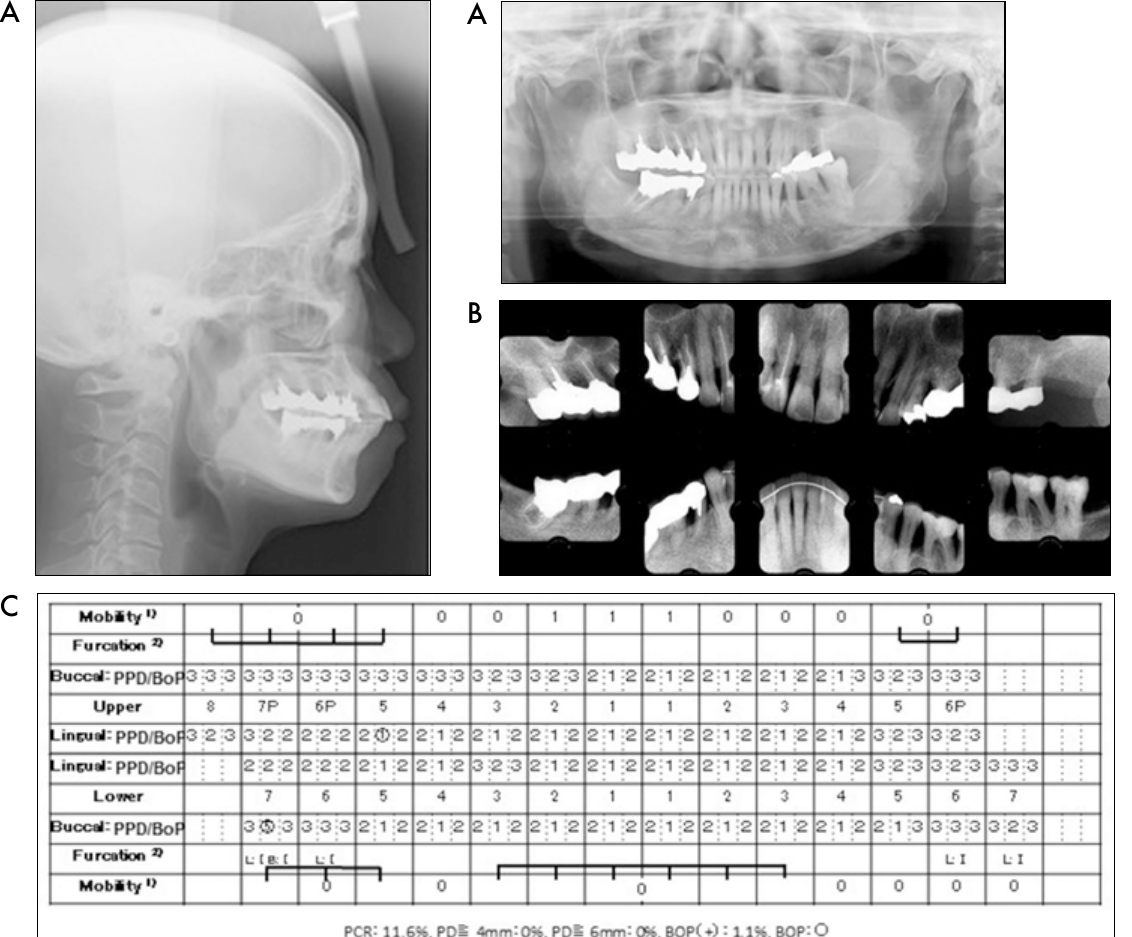
Figure 10. Clinical conditions at the two-year post-retention. A: Pantomographic and cephalometric X-ray photographs. B: Periapical radiographs. C: Periodontal chart. 1) According to the classification by Miller (1964), 2) According to the classification by Hamp et al. (1975). PPD: Probing Pocket Depth, BoP: Bleeding on Probing.